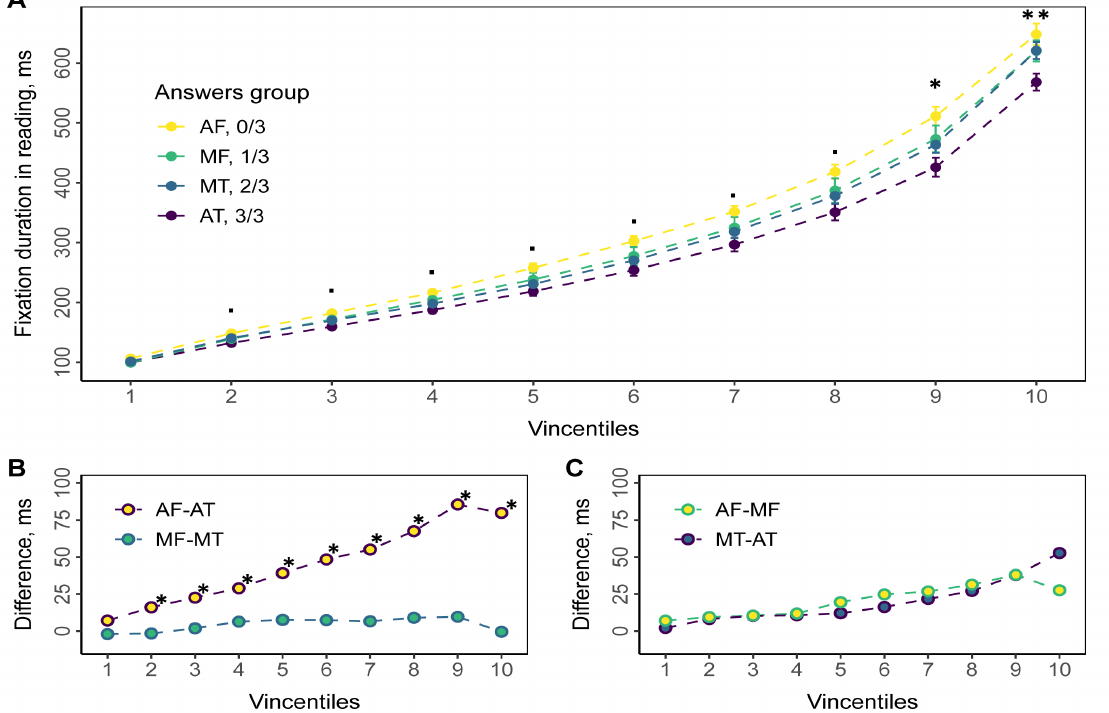
Figure 4. Empirical vincentiles for fixation durations in reading. Every vincentile consists of 10% of ordered fixation duration data. Points represent mean value averaged across all participants; error bars reflect standard errors. Colors stand for answers groups. A. Group empirical vincentiles. Significance level based on the one-way ANOVA: ∙ p < 0. 1, * p < 0. 05, ** p < 0. 01. B, C. Difference in mean fixation duration for answers groups. Significance level based on the pair-wised t-test: * p < 0.